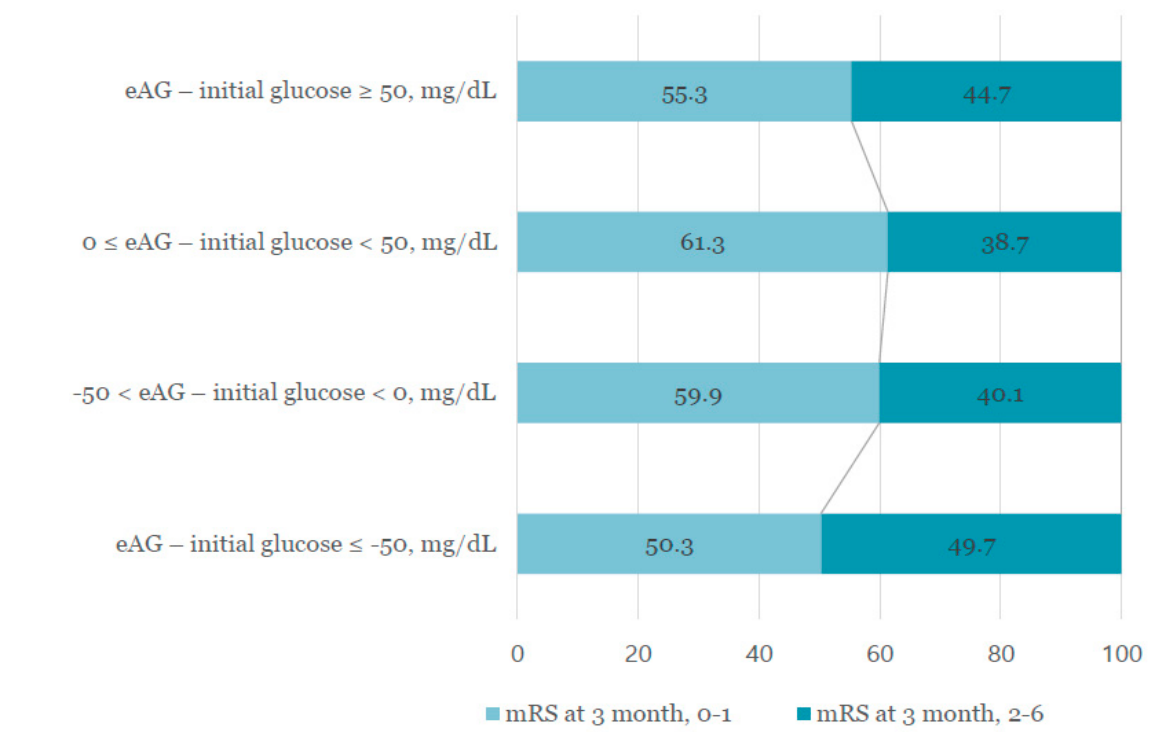
Figure 2. Distribution of levels of glucose gap groups after dichotomizing modified Rankin scale (mRS) at three months after stroke onset (mRS 0–1 versus mRS 2–6). Table 2. Baseline characteristics grouped by weight change.